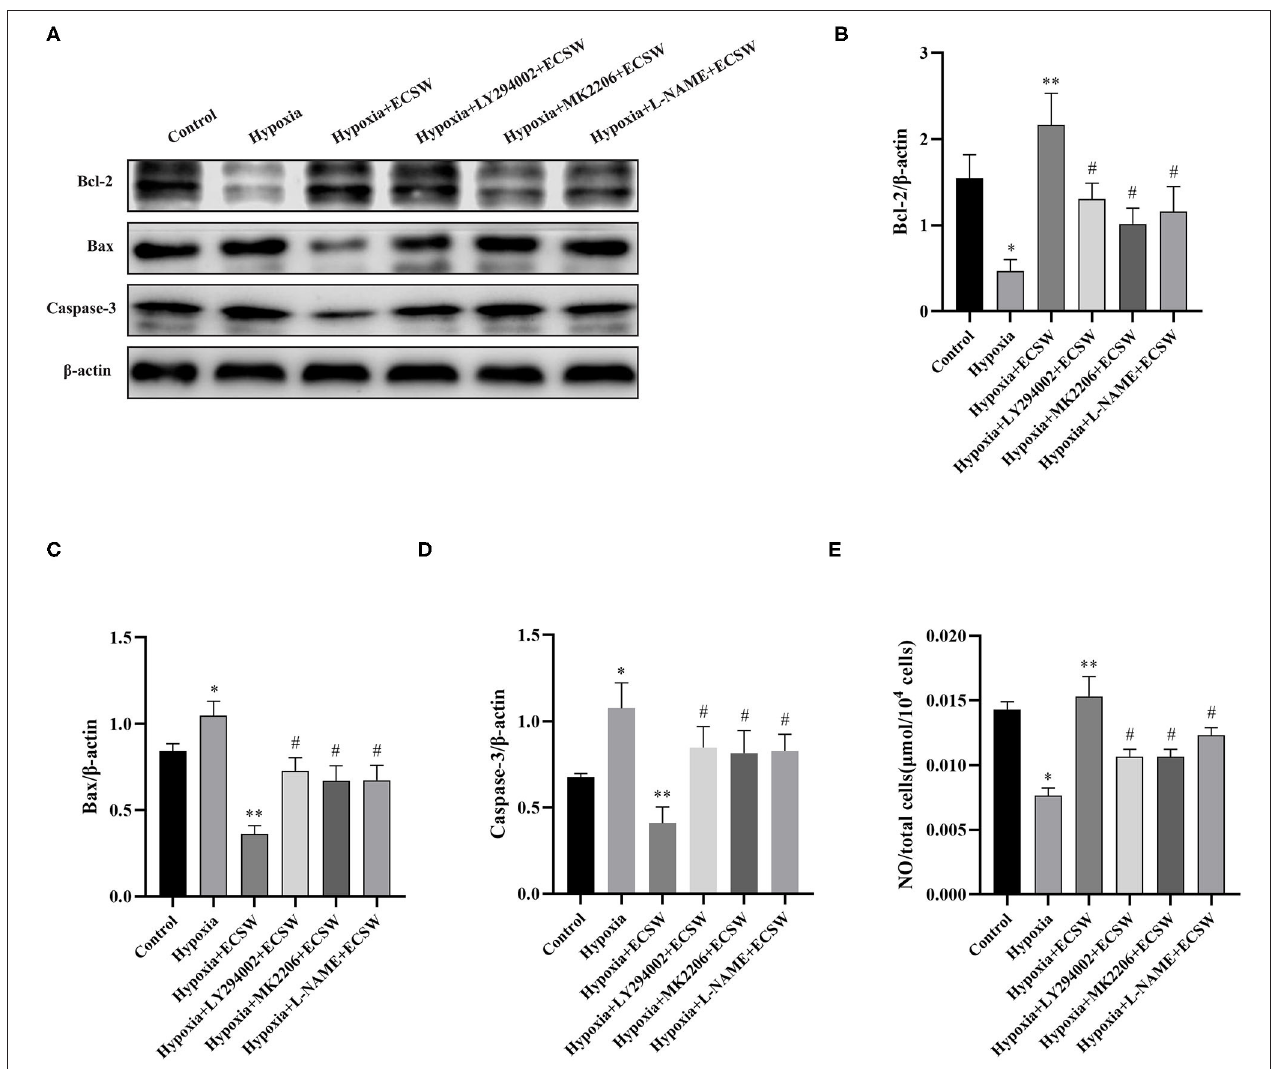
FIGURE 6 | ECSW promote the expression of Bcl-2, increases NO Production, and inhibits the expression of Bax and Caspase3 in EPCs after hypoxic injury by activating PI3K/Akt/eNOS signaling pathway. (A) The expression of Bcl-2, Bax, Caspase3, and β -actin proteins of EPCs in each group. (B–D) Quantification analysis of Bcl-2, Bax, and Caspase3 expression levels, respectively. (E) Quantitative analysis of NO production of EPCs in each group. Data are presented as mean ± SD, N = 3. * P < 0.05 vs. group control, ** P < 0.05 vs. group hypoxia, # P < 0.05 vs. group hypoxia +